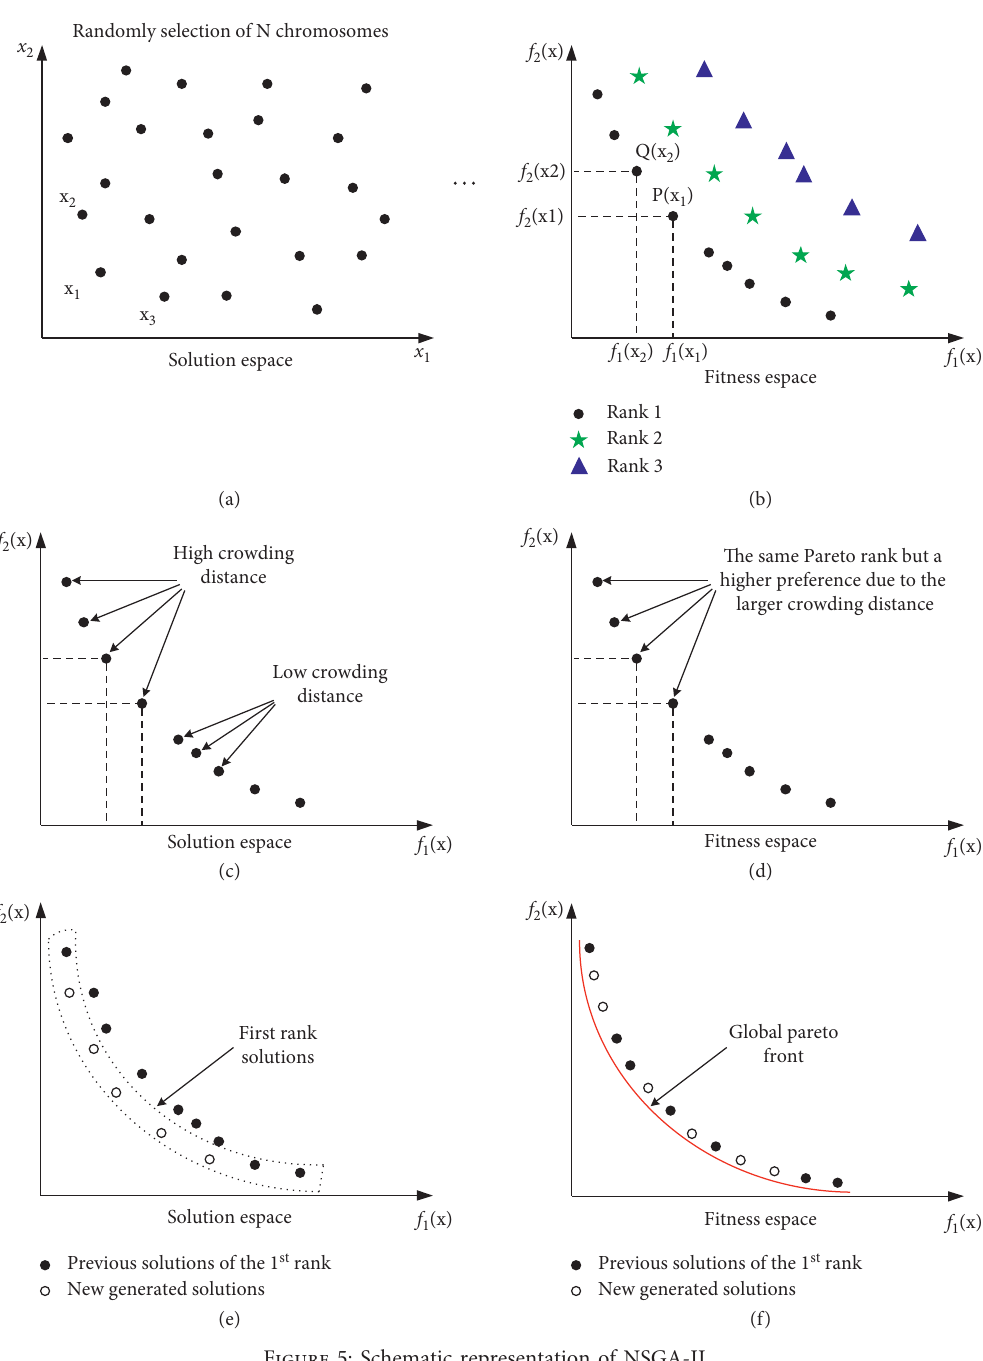
Figure 5: Schematic representation of